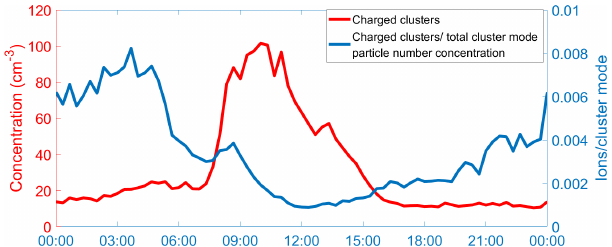
Figure 14. Diurnal pattern of charged clusters (1.5–3nm) number concentration (red line) and ratio of charged clusters to total cluster mode (1.5–3nm) particle number concentration on the NPF event days (blue line). The time resolution of the used data was 12min.